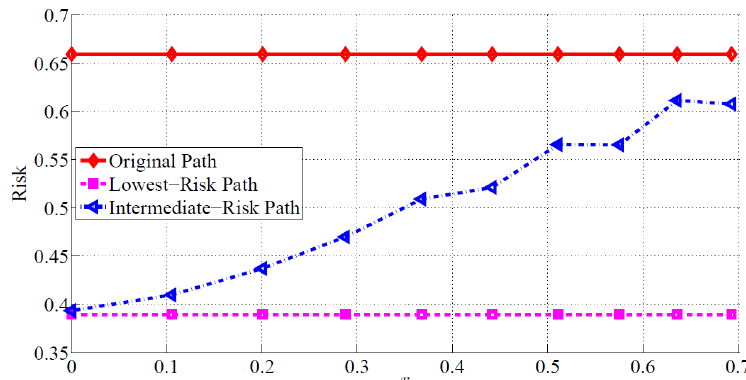
Figure 6. Risk threshold versus adaptive risk threshold.